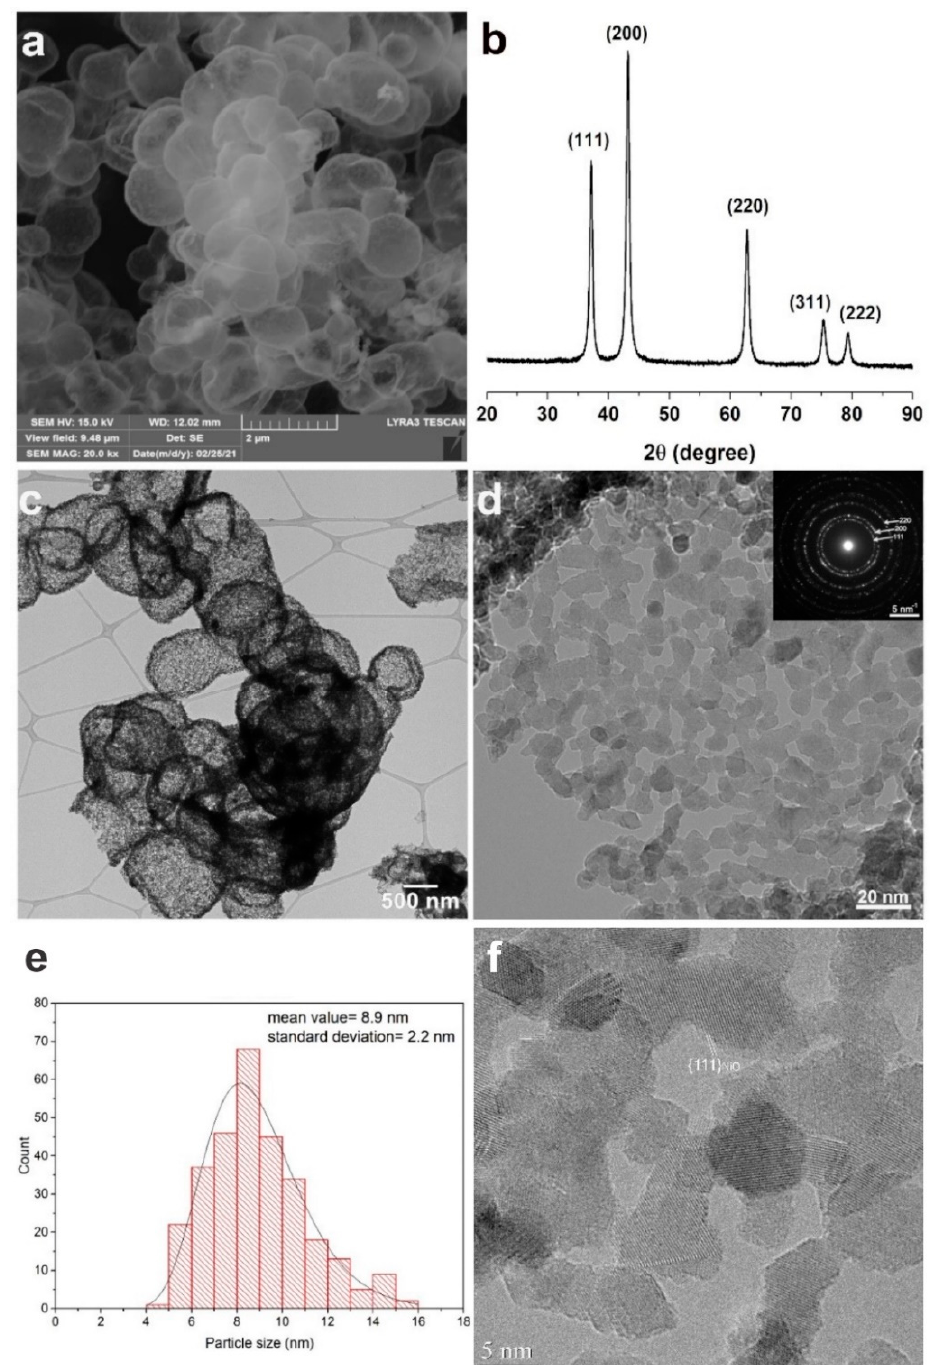
Figure 2. SEM image revealing the growth morphology as micrometric quasi-spherical formations ( a ); XRD pattern proving the synthesis of single-phase cubic NiO ( b ); low-magnification TEM image confirming the quasi-spherical formations ( c ); high-magnification TEM image and inserted SAED pattern showing the nanostructure of the quasi-spherical formations ( d ); nanoparticle size distribution from TEM imaging on the NiO sample ( e ); HRTEM image of the NiO nanoparticles, showing the lack of structural defects and the single-domain nature for most of them ( f